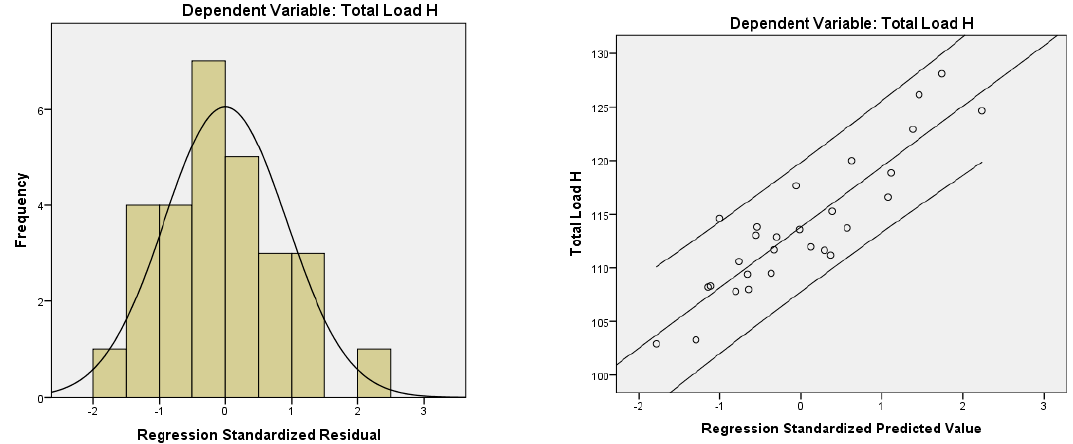
Figure 13. Statistical tests for Heraklion’s regression model.